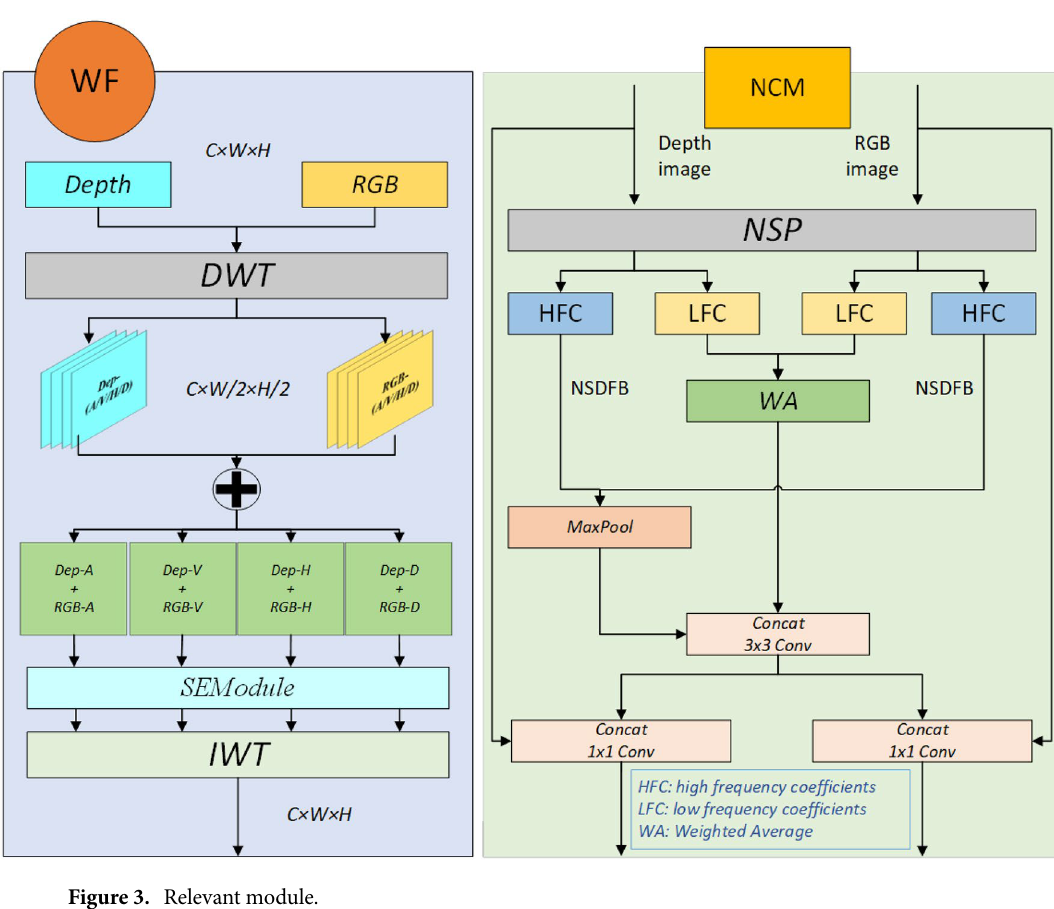
Figure 3. Relevant